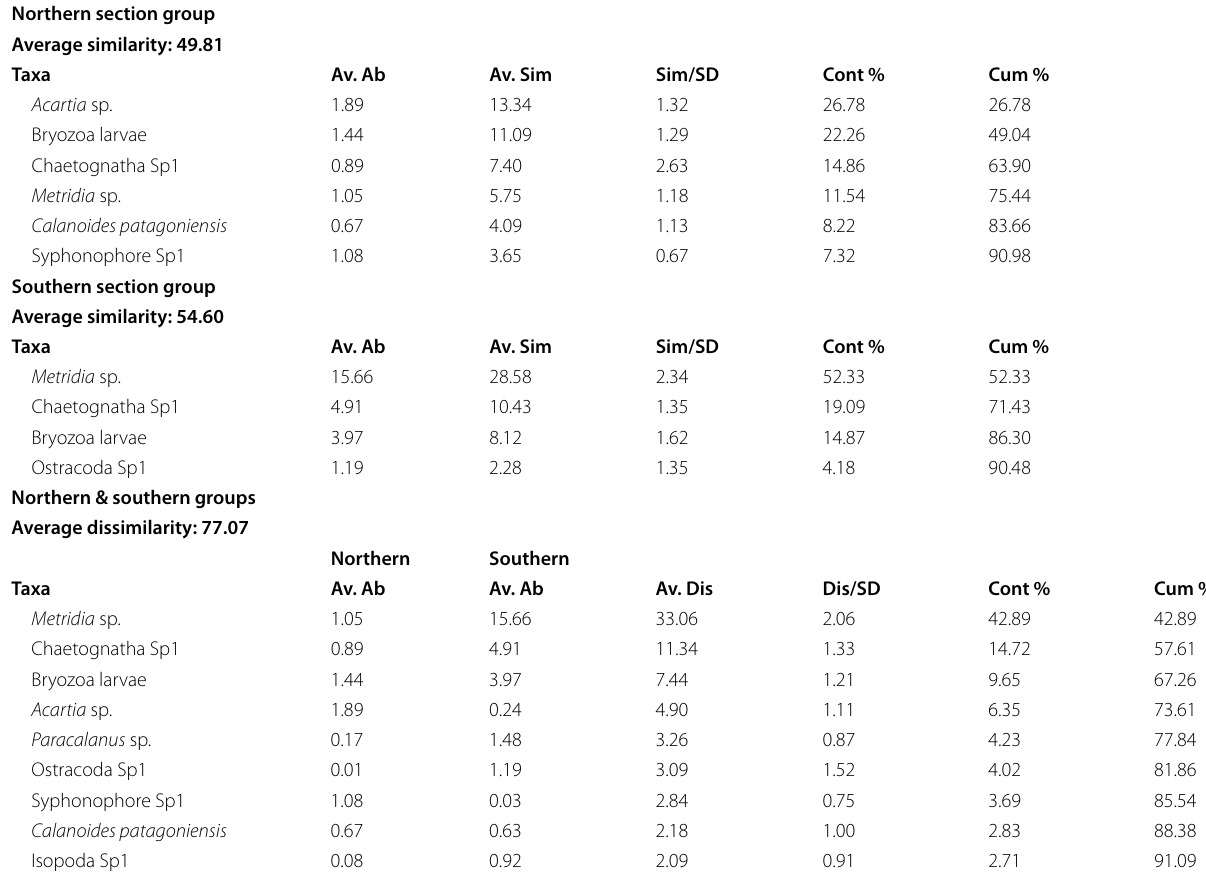
Table 5 Results of the SIMPER analysis for the zooplankton community in the deeper stratum of the Caucahué Channel. Av: Average, Ab: Abundance, Sim: Similarity, Dis: Dissimilarity, Cont %: Taxa percentage contribution, Cum %: Cumulative percentage taxa